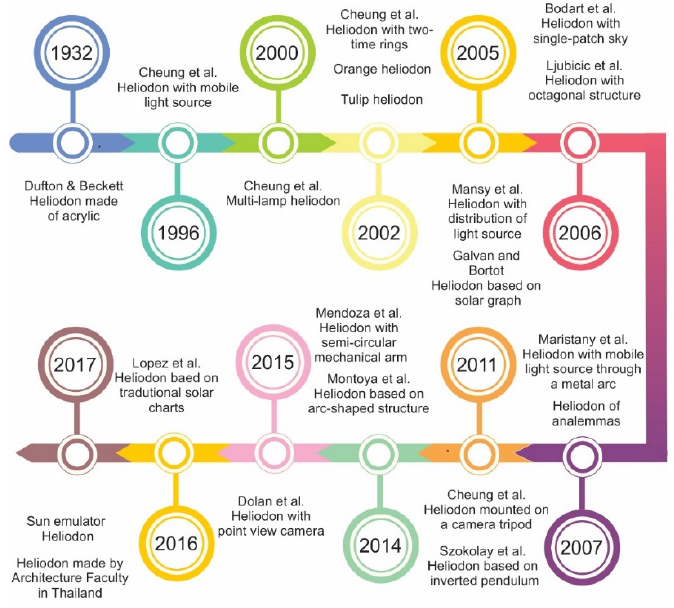
Figure 12. Historic evolution of heliodon.